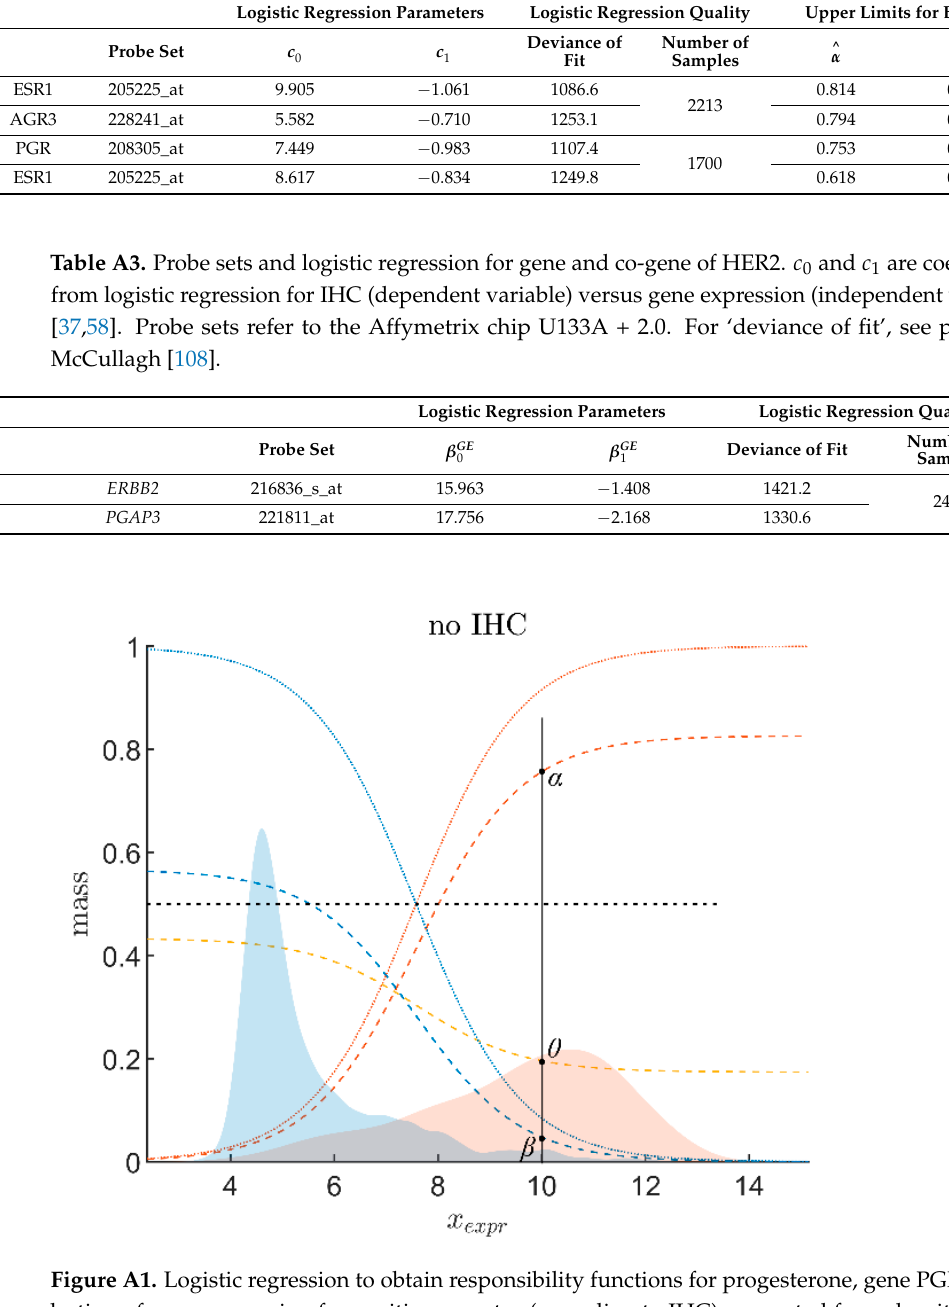
Figure A1. Logistic regression to obtain responsibility functions for progesterone, gene PGR. Distri- bution of gene expression for positive receptor (according to IHC) computed from density kernel estimates [71–73], shown red shaded, for negative IHC, blue shaded. Responsibility functions for receptor positivity, r + (dotted red curve) and r − (dotted blue) were obtained in this way. Belief in positive ( α ): solid red, belief in negative ( β ): solid blue and uncertainty ( θ ): solid